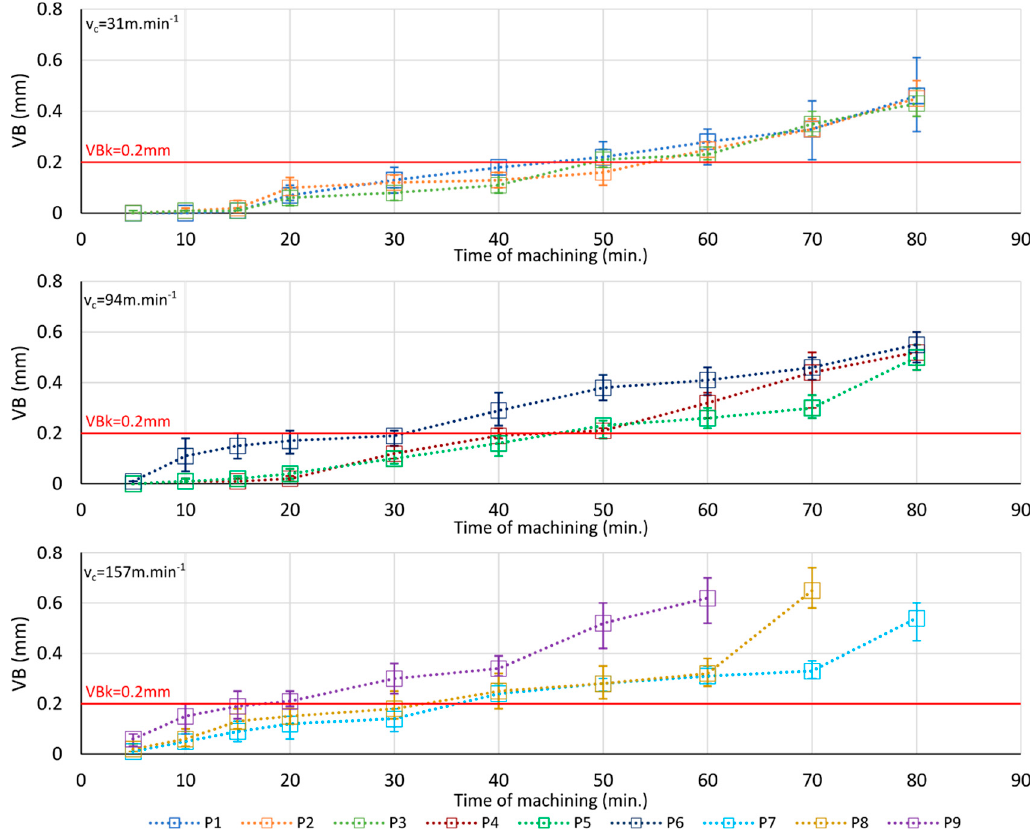
Figure 7. The graphical course of tool wear at various cutting parameters of trochoid machining (see the table 4 with conditions P1–P9)—classified by cutting force.